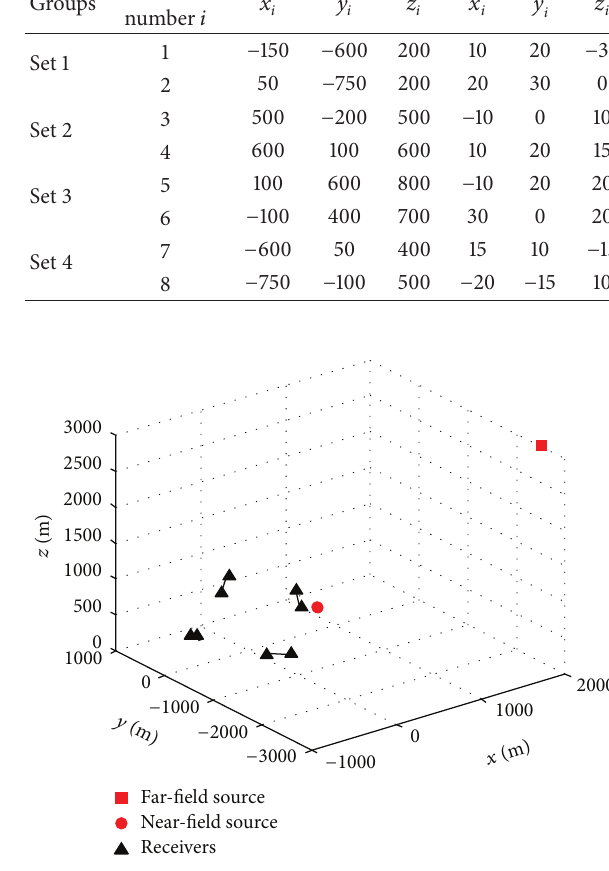
Figure 2: Localization geometry for simulation.